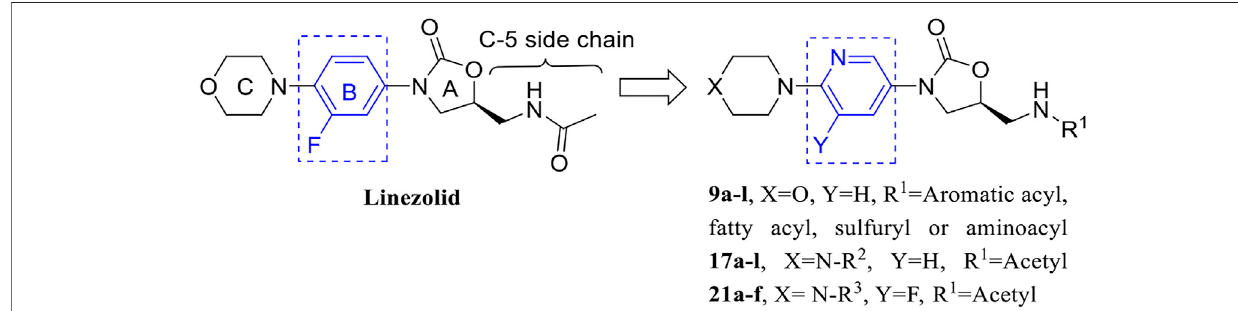
FIGURE 1 | Optimization strategy of 3-(pyridine-3-yl)-2-oxazolidinone derivatives.